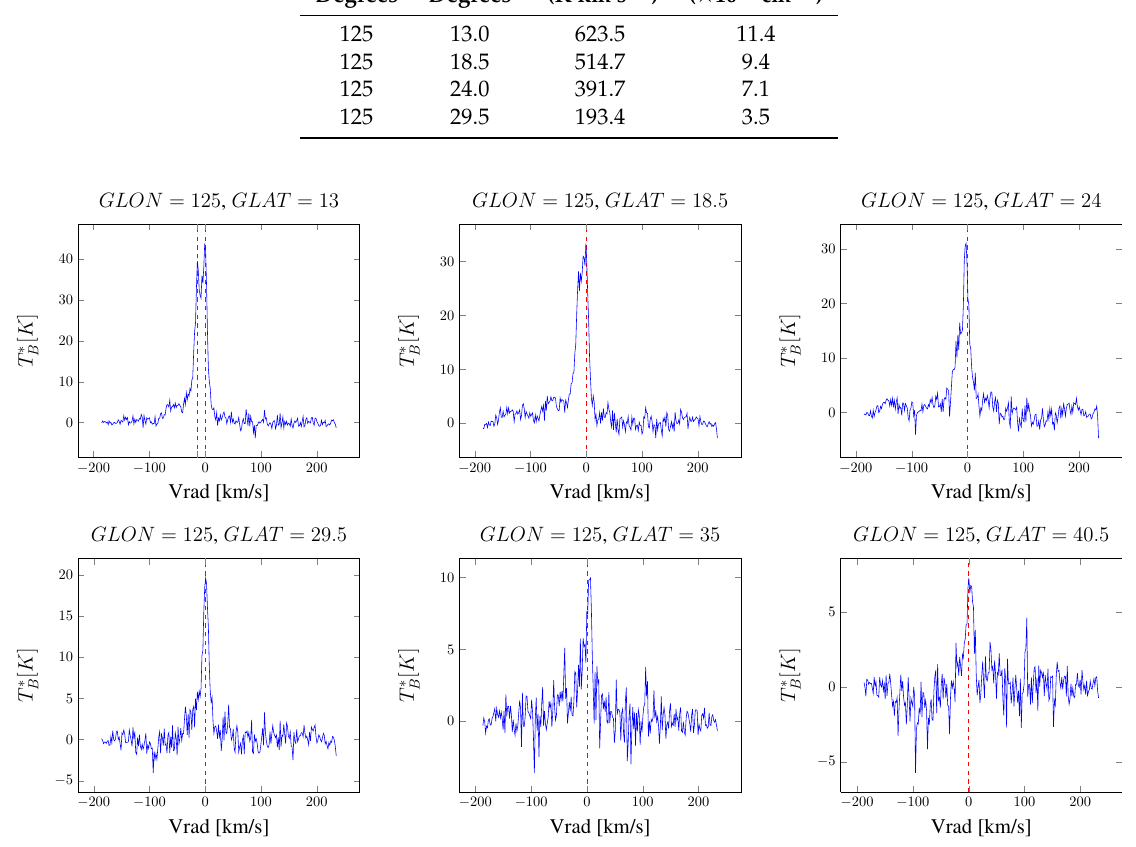
Figure 2. Neutral atomic hydrogen (HI) 21-cm emission line observed toward six positions in the Milky Way. The dashed red line indicates the 0 km s − 1 velocity in all of the panels. In the upper-left panel, the velocity of 20 km s − 1 —corresponding to another gas component with a radial velocity different − than 0 km s − 1 —is also